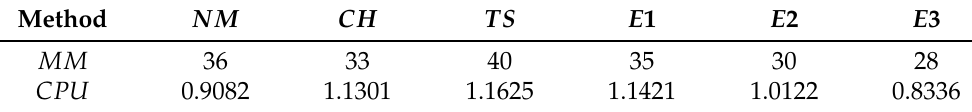
Table 5. Results of Example